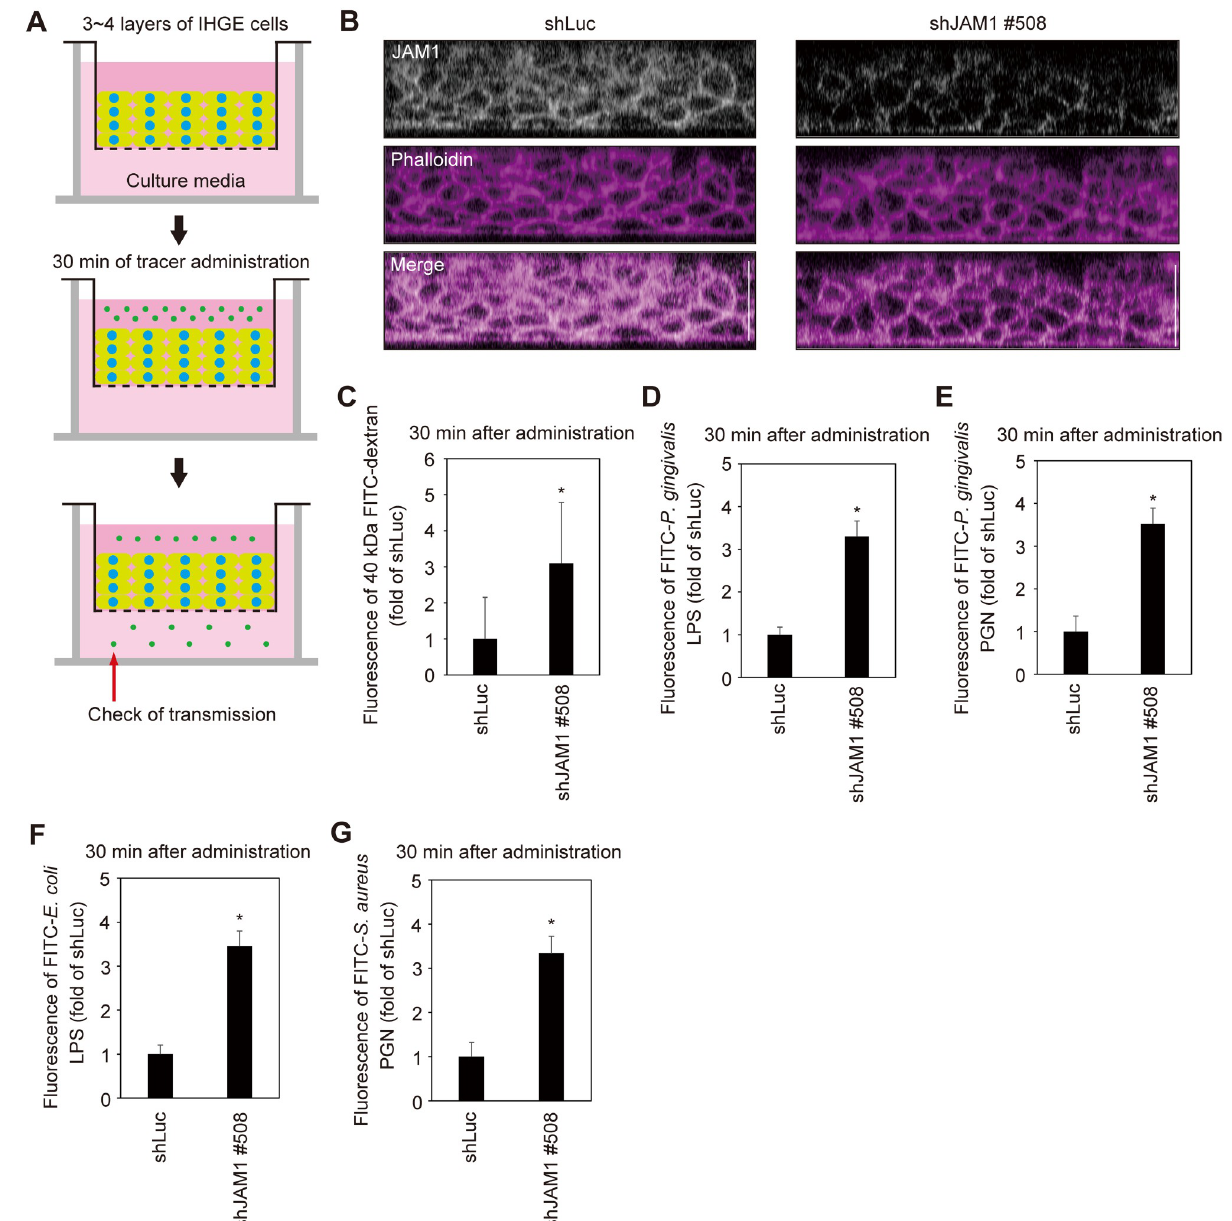
Fig 7. JAM1 is required for epithelial barrier function of gingival epithelial tissues. (A, B) Schematic illustration (A) and confocal microscopic cross-sectional images (B) of 3D-tissue model expressing shLuc or shJAM1. Gingival epithelial tissues were fixed, stained with anti-JAM1 (white) and Alexa Fluor 568–conjugated phalloidin (magenta), and analyzed by confocal microscopy. Scale bars, 30 μ m. (C – G) Permeability to 40 kDa FITC– dextran (C), FITC– P . gingivalis LPS (D), FITC– P . gingivalis PGN (E), FITC– E . coli LPS (F), and FITC– S . aureus PGN (G) in gingival epithelial tissues expressing shLuc and shJAM1. Results are expressed as fold change relative to epithelium expressing shLuc and are the means ± SD of seven technical replicates. � , p < 0.05, one-tailed t test (C–E).